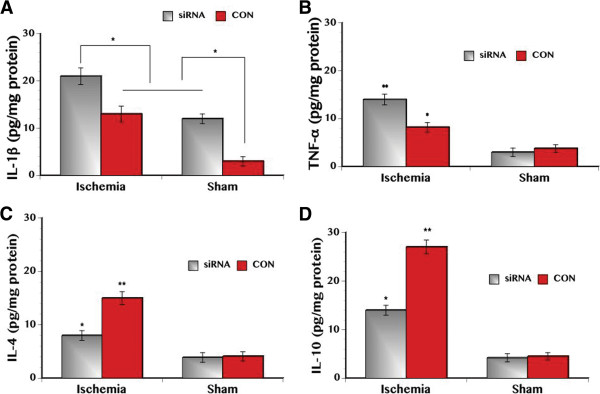
Cytokine expression in transient global cerebral ischemia and CX3CR1 deficiency was detected using ELISA. (A) Significant increase in IL-1β expression was seen following transient global cerebral ischemia, which was amplified by CX3CR1 deficiency. Silencing of CX3CR1 function in sham rats also resulted in increased IL-1β expression. (B) Expression of TNF-α also increased significantly following ischemic injury and intensified by CX3CR1 deficiency. Low level TNF-α expression was seen in the sham animals and no significant group difference was seen. (C) Ischemic injury also significantly elevated the expression of the anti-inflammatory cytokine IL-4 but the upregulation was mitigated by CX3CR1 deficiency. Low level IL-4 expression was seen in the sham animals and no significant group difference was seen. (D) Similarly, IL-10 expression significantly increased after ischemic injury but the upregulation was mitigated by CX3CR1 deficiency. Low level IL-10 expression was seen in the sham animals and no significant group difference was seen. *P <0.05 and **P <0.01.